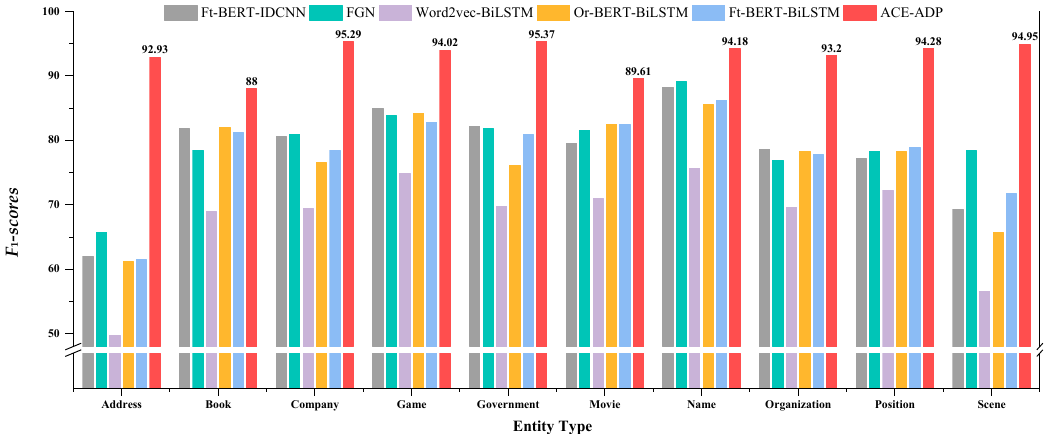
Figure 5. Detailed results of F 1 -scores for each category on CLUENER.